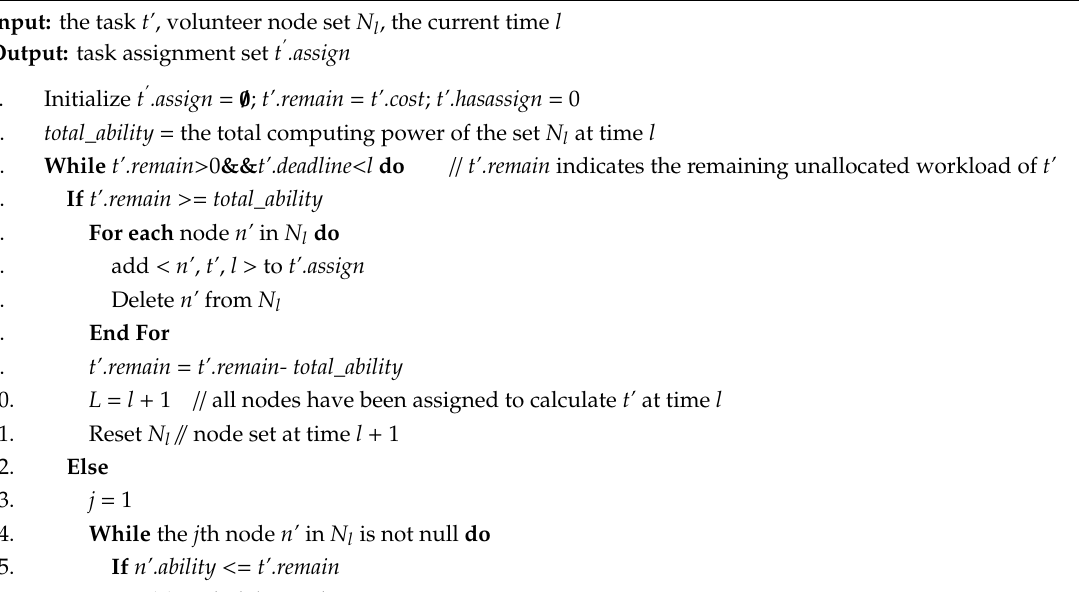
Algorithm 2. The Match( t’ , N l , l